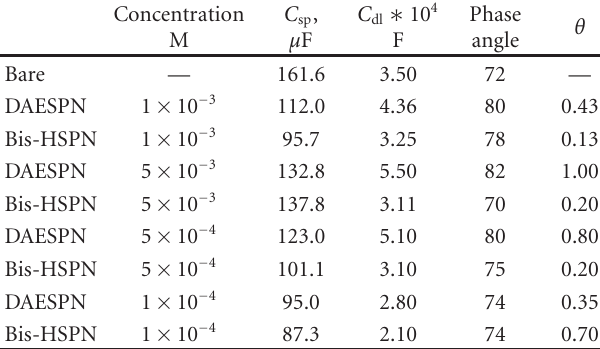
Table 2: Specific ( C sp ) and double layer capacitance ( C dl ), phase angle and surface coverage values for SS electrode in the presence and absence of di ff erent concentrations of DAESPN and Bis-HSPN in 3.0 M NaCl